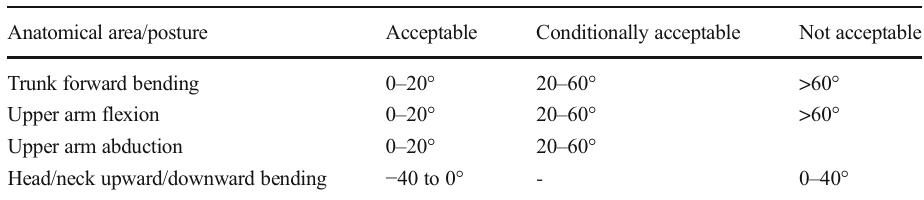
Norma BSEN 1005 – 4: 2005 + A1: